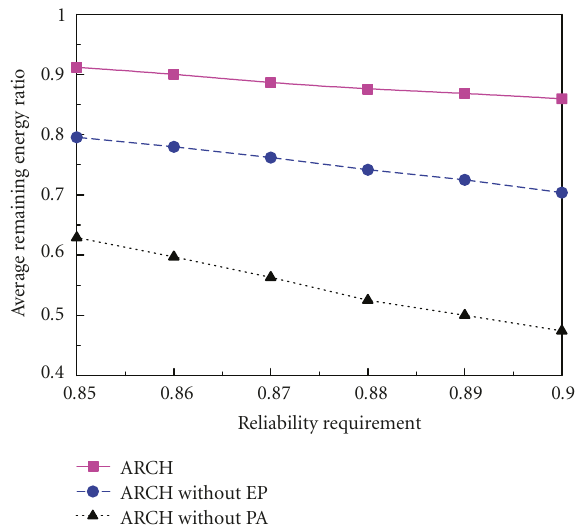
Figure 10: Remaining energy ratio with reliability requirement.